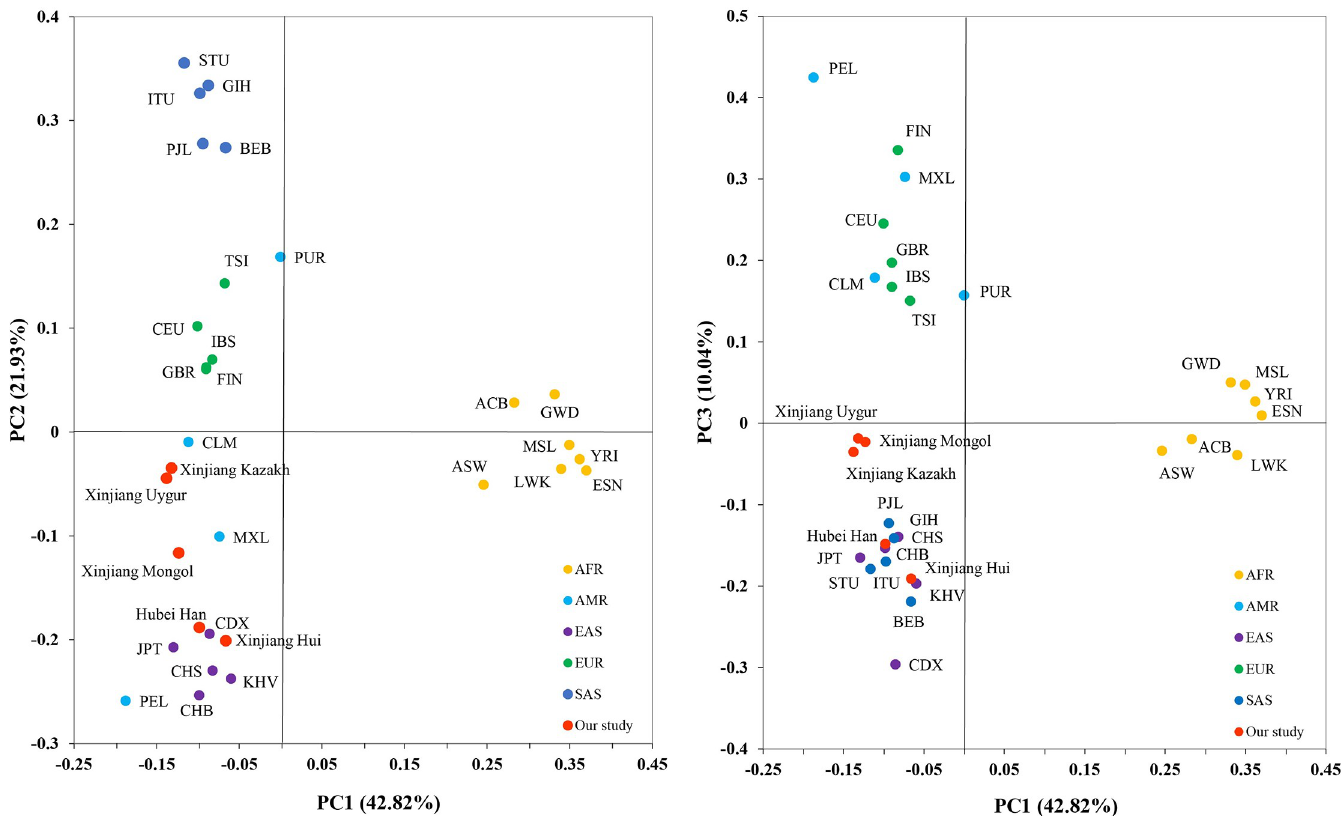
Fig 5. Principal component analysis of the 31 populations based on allele frequencies of the 31 InDels. PC1 and PC2 account for 64.75% of the total variation, and PC3 account for 10.04% of the total